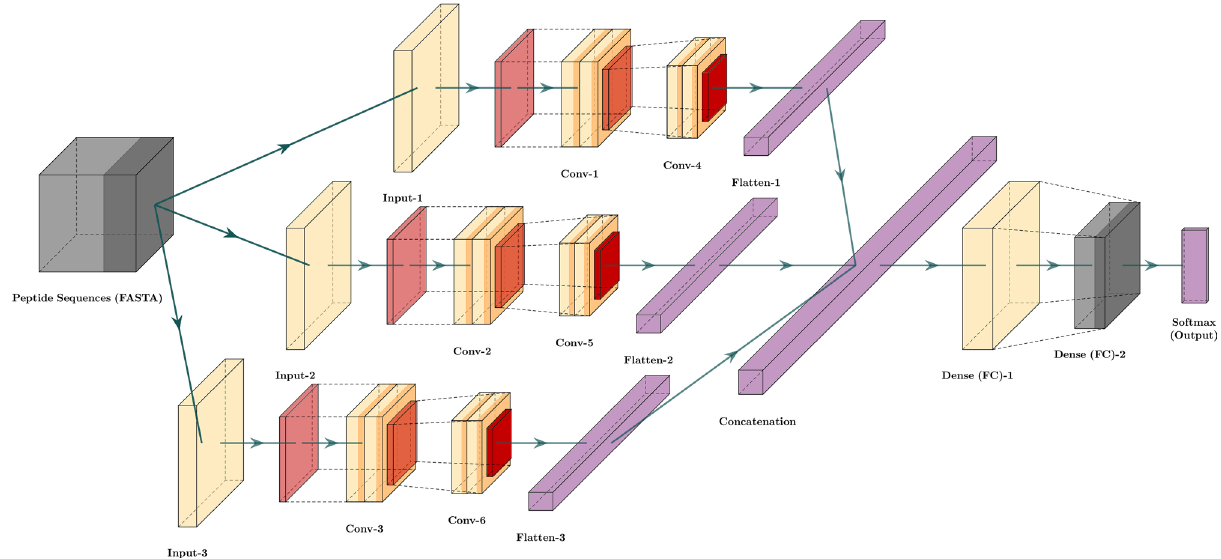
Figure 1. The general architecture of ACP-MHCNN. We extract BPF, physicochemical, and evolutionary-based features. We then feed the extracted features to a multi-headed deep convolutional neural network (MHCNN) to predict Anti-Cancer